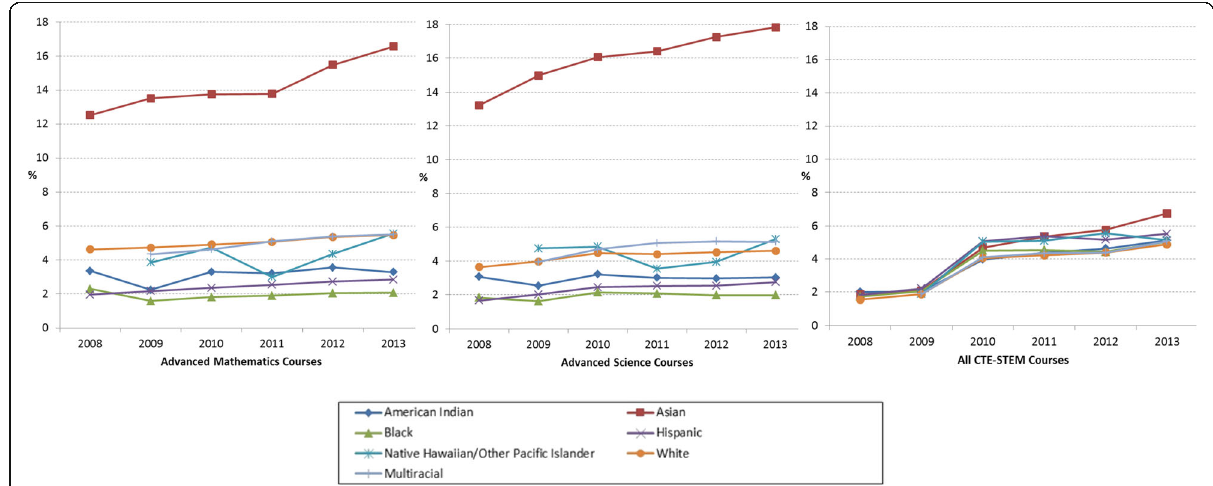
Fig. 12 Advanced mathematics, advanced science, and CTE-STEM course enrollment rates in percentage of total number of students in each racial/ethnic group from 2008 to 2013